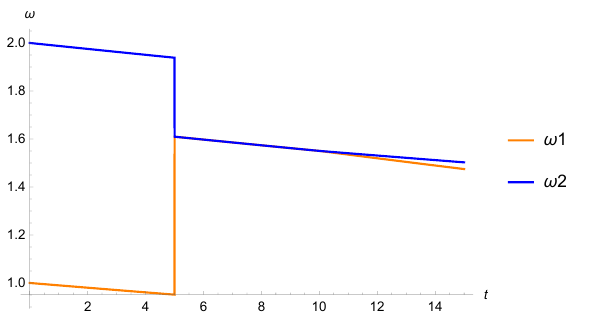
Figure 21. Simulation of the Clutch model with resets. Mode change F mode change T F occurs at t = 10 →